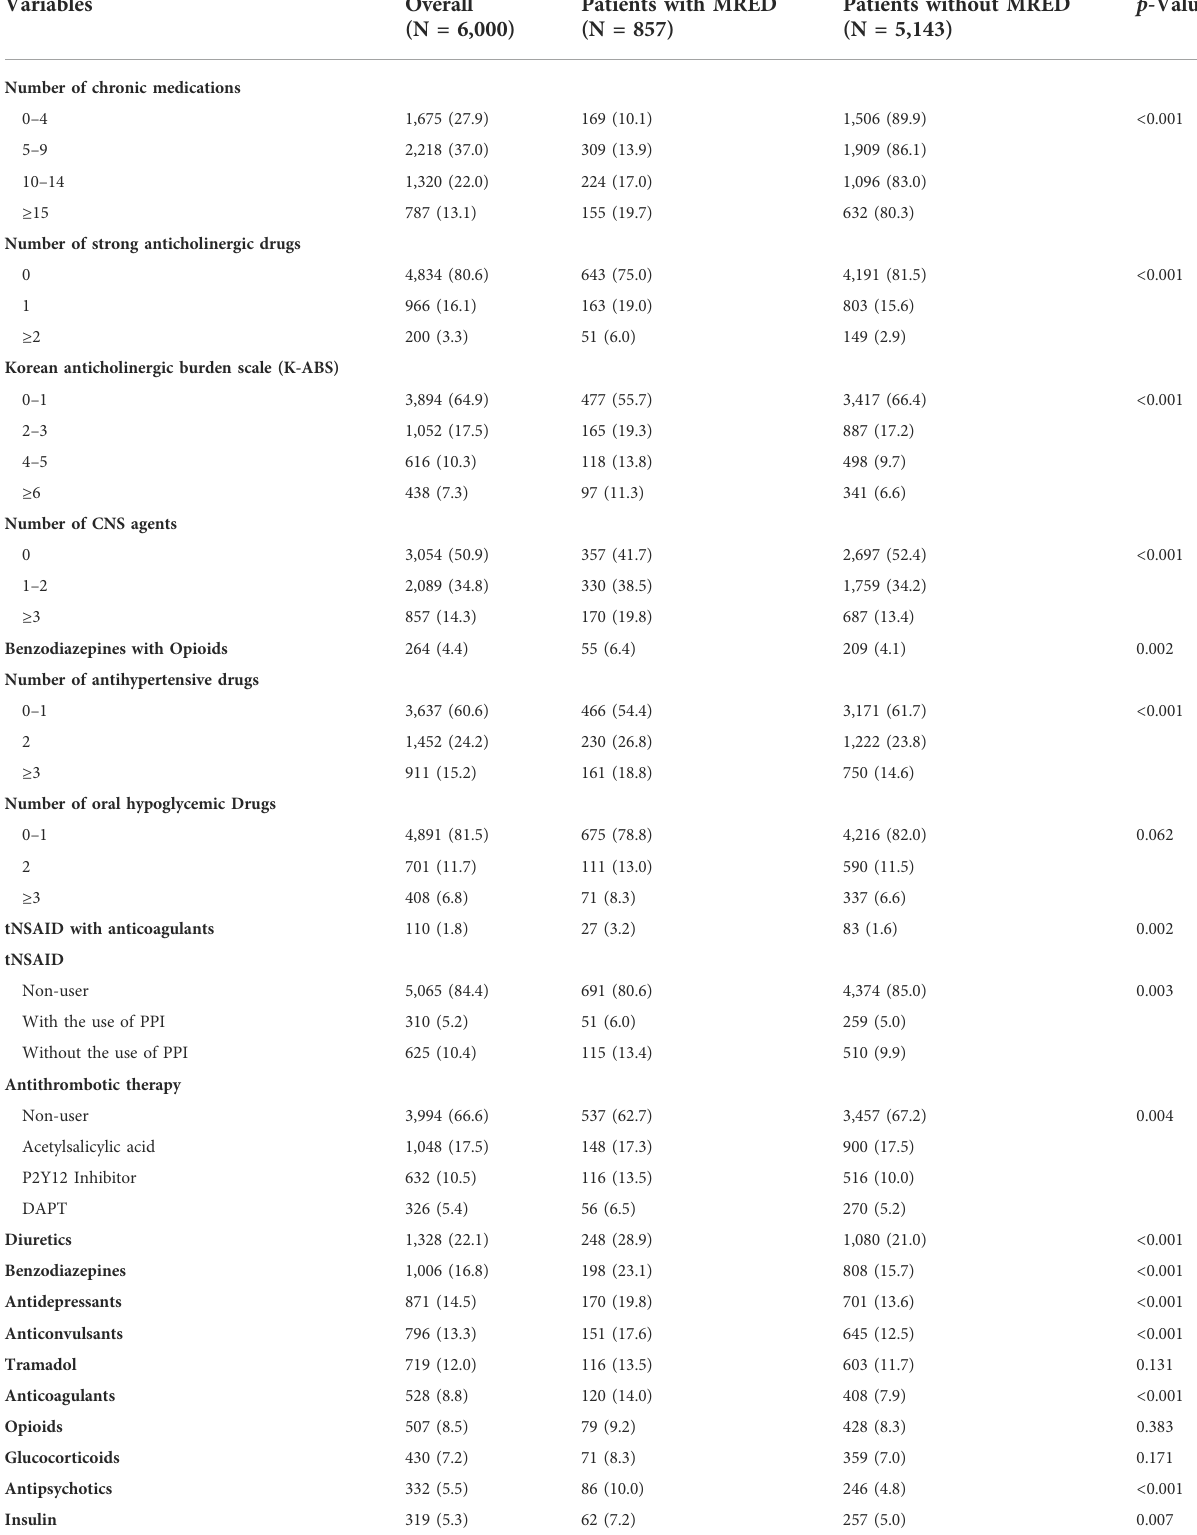
TABLE 2 Medication use pattern of the study